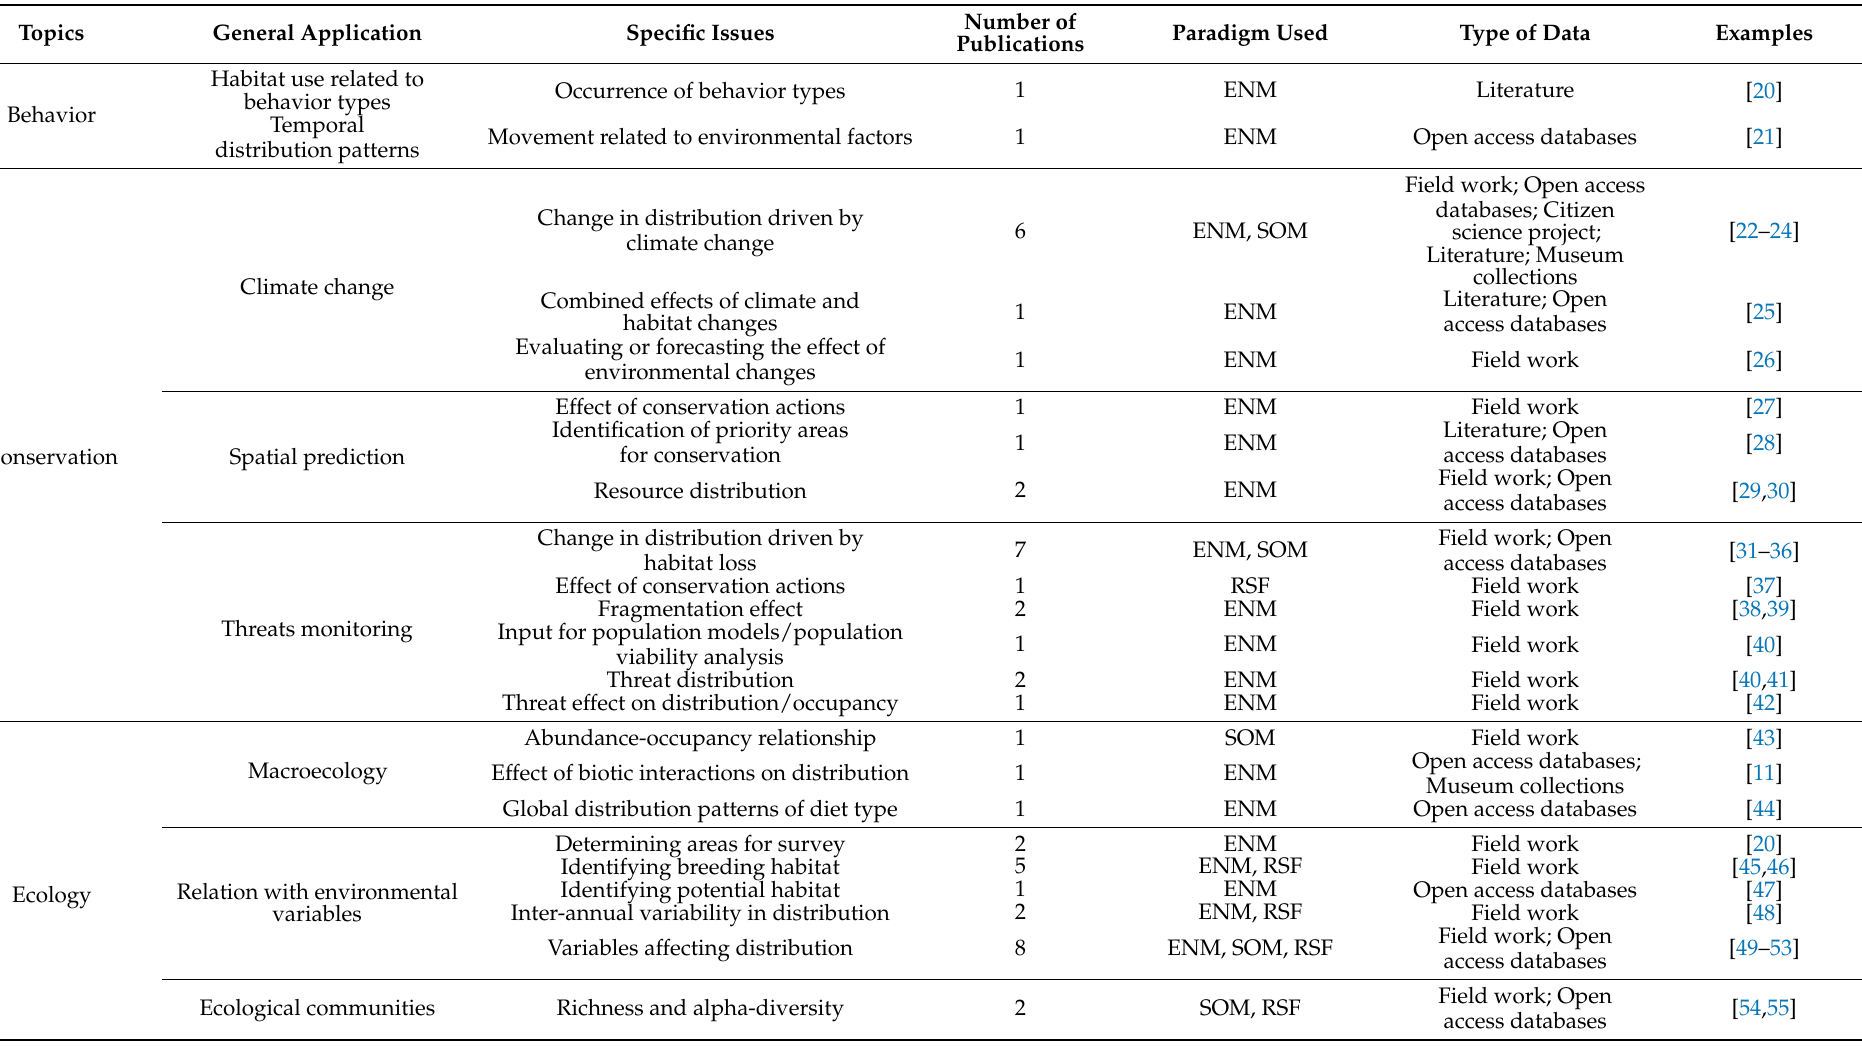
Table 1. Major topics addressed in the parrot distribution modelling literature, with general and specific applications and relative examples taken from published case studies. The modelling paradigm and type of data used are shown. ENM = Environmental (or ecological) niche modelling. RFS = Resource Selection Function. SOM = State Observation